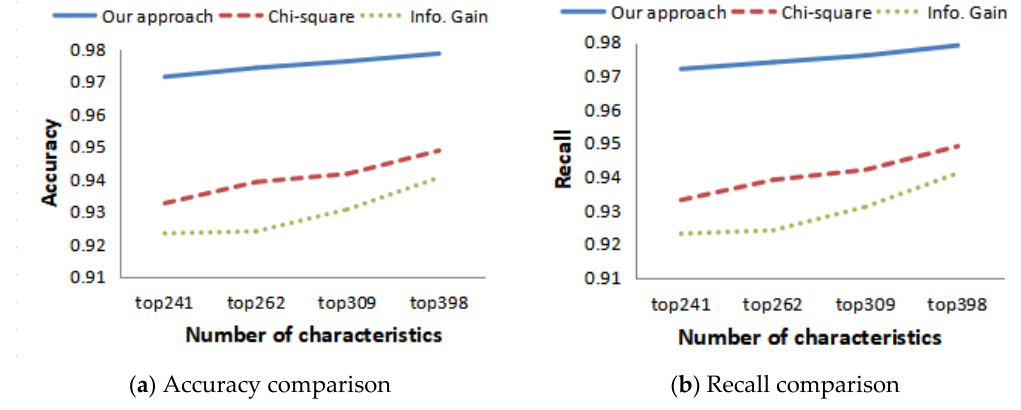
Figure 8. Performance comparisons.